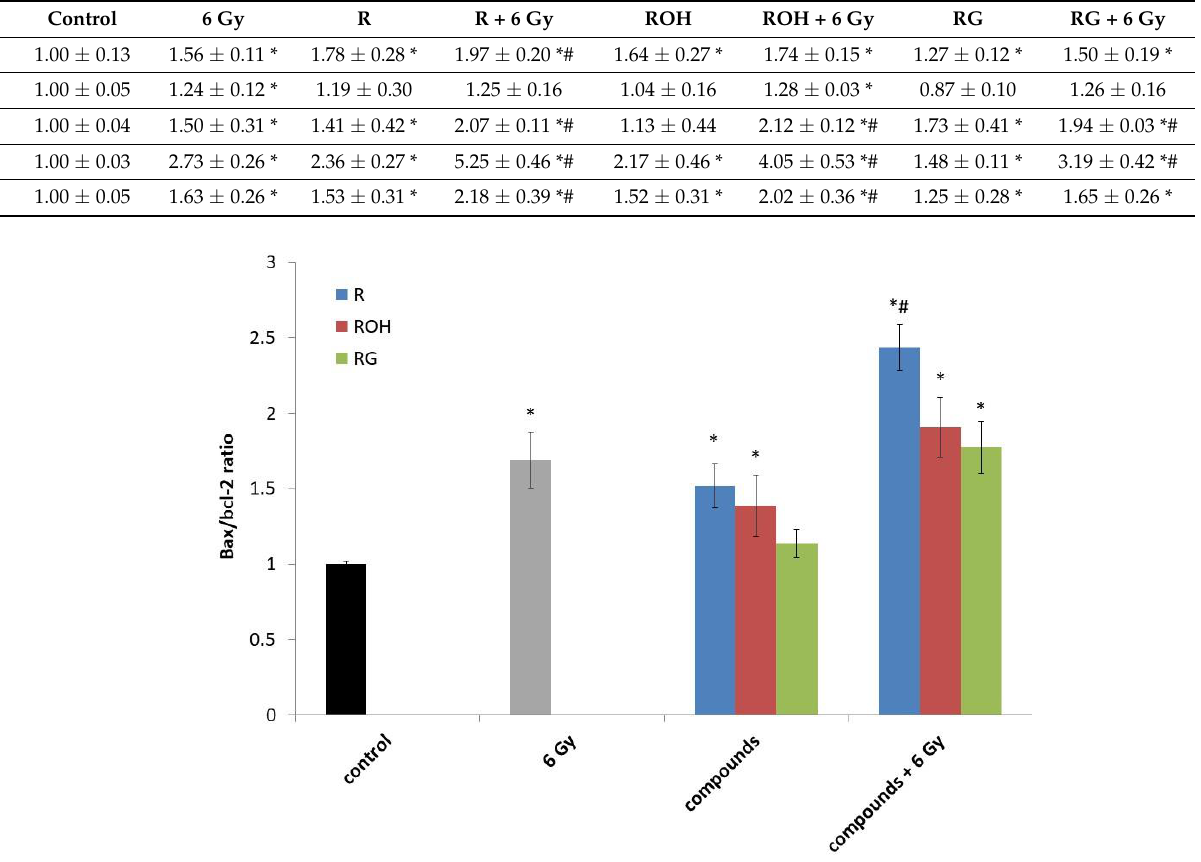
Figure 5. The Bax/Bcl-2 ratio in the MCF-7 cells treated with 25 μM of resveratrol (R), piceatannol (ROH), and piceid (RG) alone and in combination with IR (dose of 6 Gy). MCF-7 cells were incubated with stilbene and/or IR for 24 h. Data are the results of three independent repetitions. Treatments were compared by a two-way analysis of variance (ANOVA) followed by Tukey’s post hoc test ( p < 0.05). The mean difference (*) was compared with the control and (#) with IR.